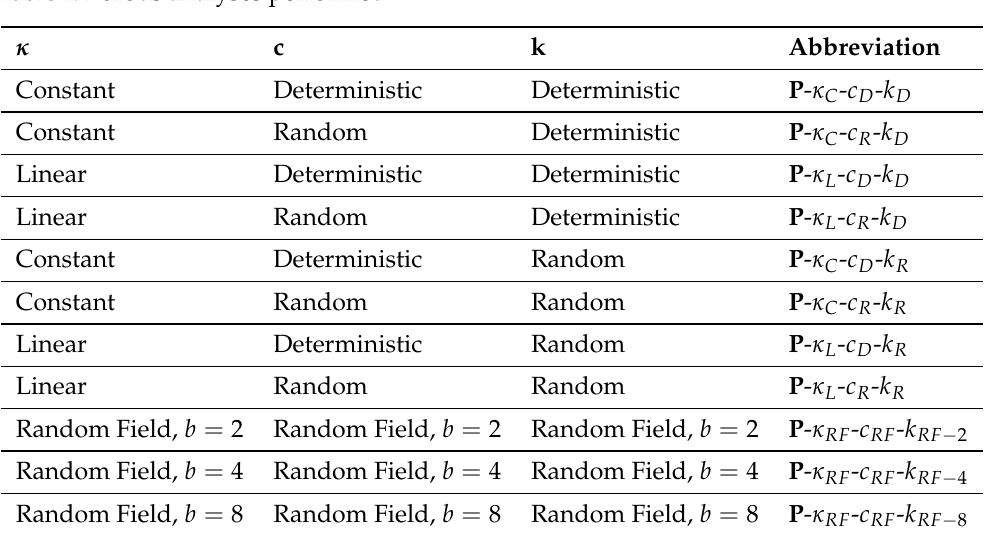
Table 4. Porous analyses